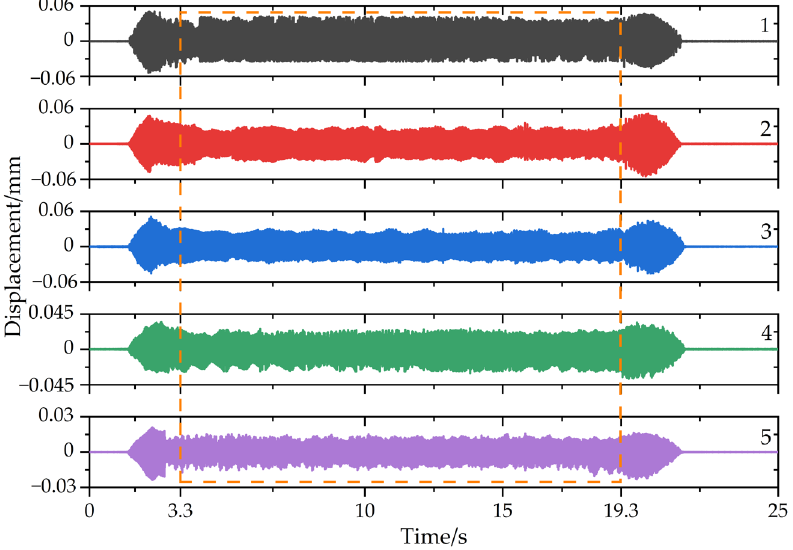
Figure 13. Workpiece displacement responses in different milling stages.